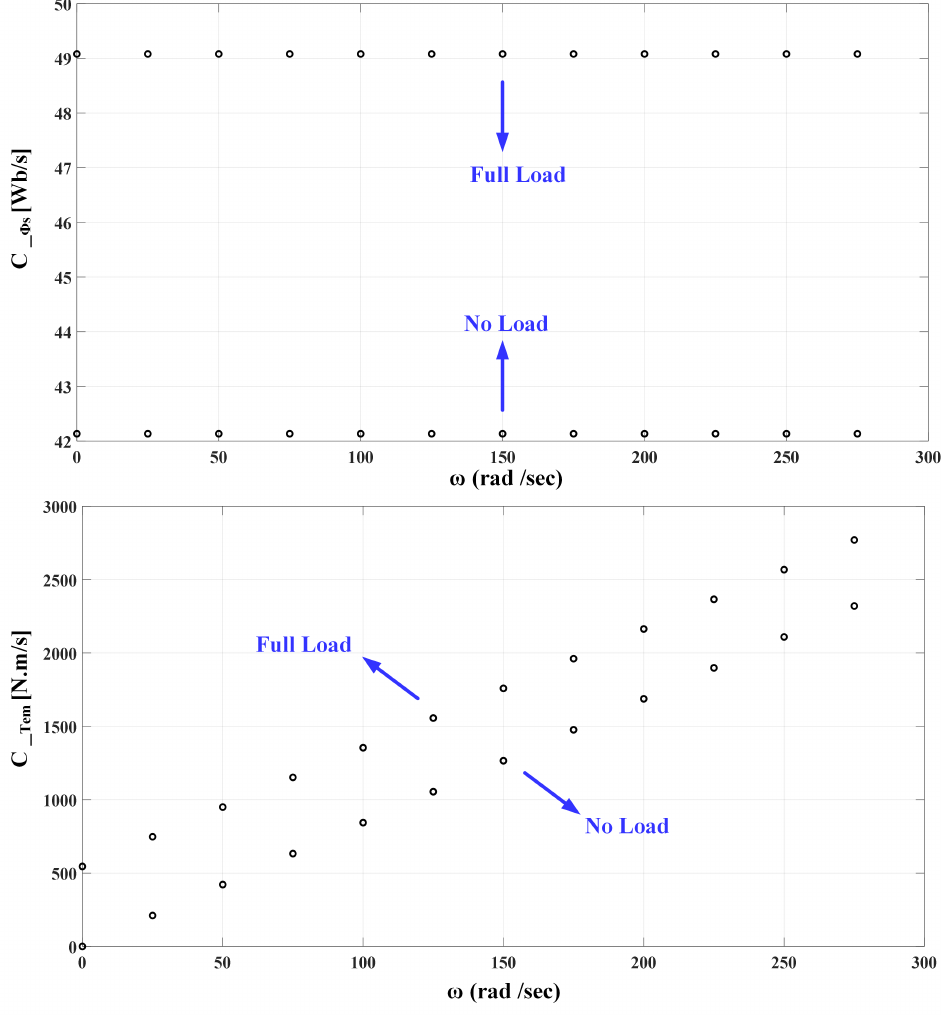
Figure 7. The effect of the zero voltage vector on both the error changes of the stator flux and the